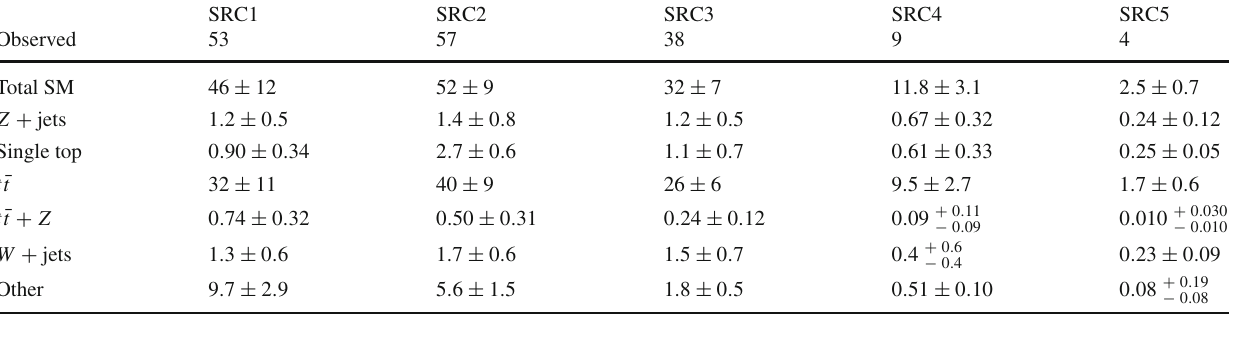
Table 13 Observed and expected yields after the background-only fit, for SRD. The uncertainties include MC statistical uncertainties, detector-related systematic uncertainties, and theoretical